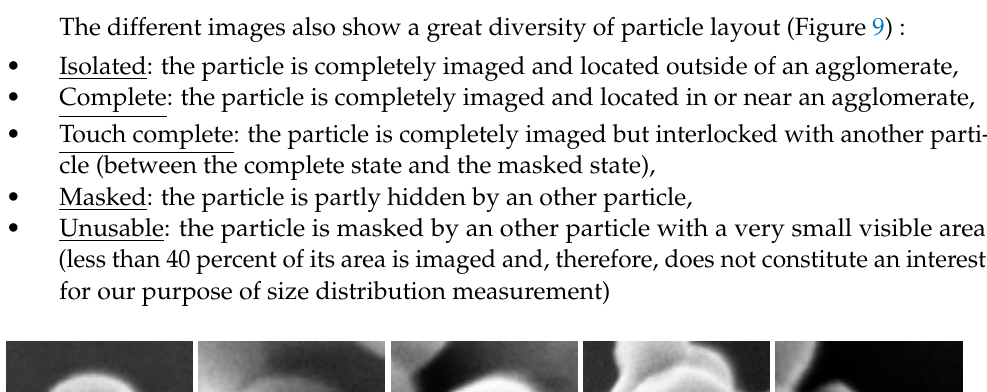
Figure 8. Test SEM images, agglomerate TiO 2 particles ( top figure ), scattered TiO 2 particles ( bottom left figure ) and with a mixture of SiO 2 and TiO 2 particles ( bottom right figure ).